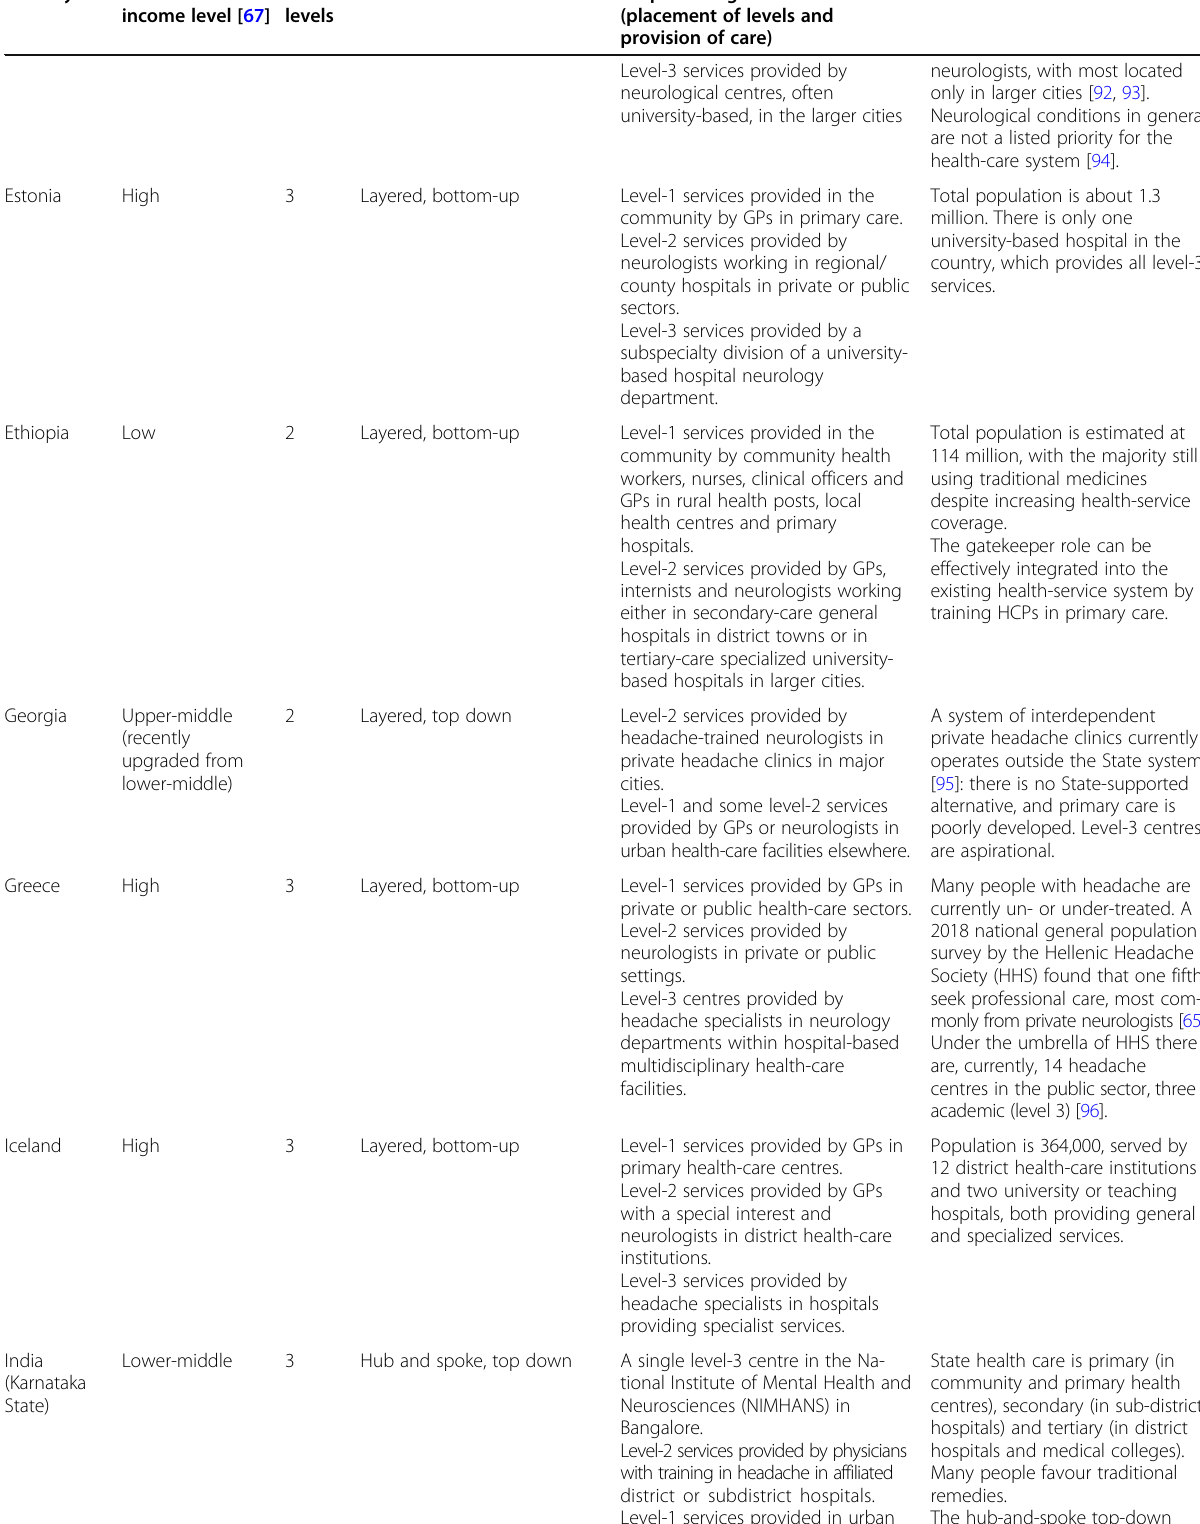
Table 7 Illustrations of how the model might be implemented, with adaptations, in various countries